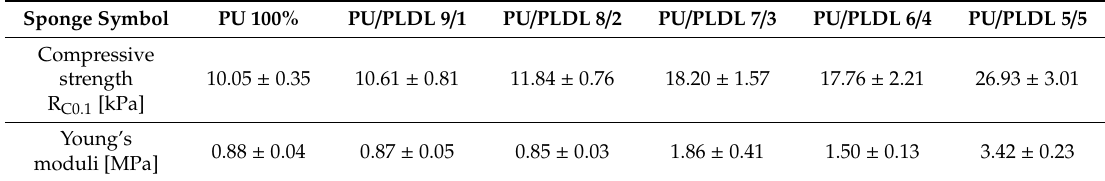
Table 1. The comparison of Young’s moduli (EC) of PU / PLDL sponges measured by static compression test and compressive yield strength RC0.1 for polymer sponges.